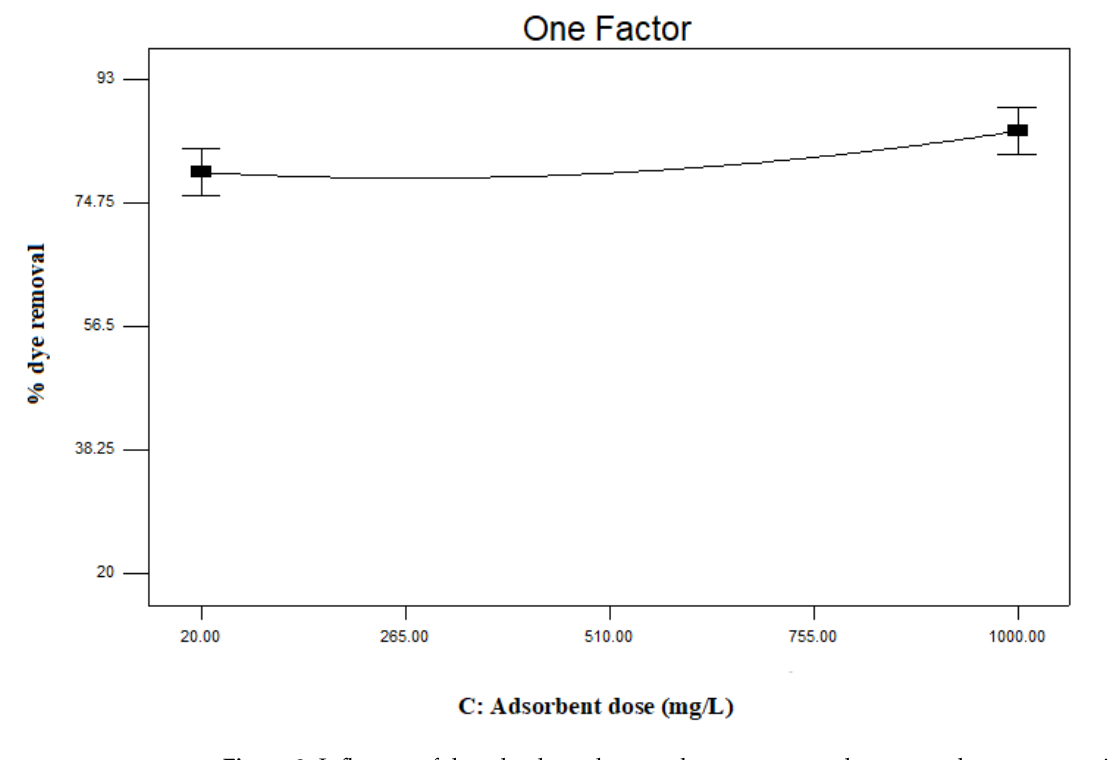
Figure 9. Influence of the adsorbent dose on the perecentage dye removal at a constant initial dye concentration (A) of 38.19 mg/L, pH (B) of nine, and time (D) of 89.75 min.